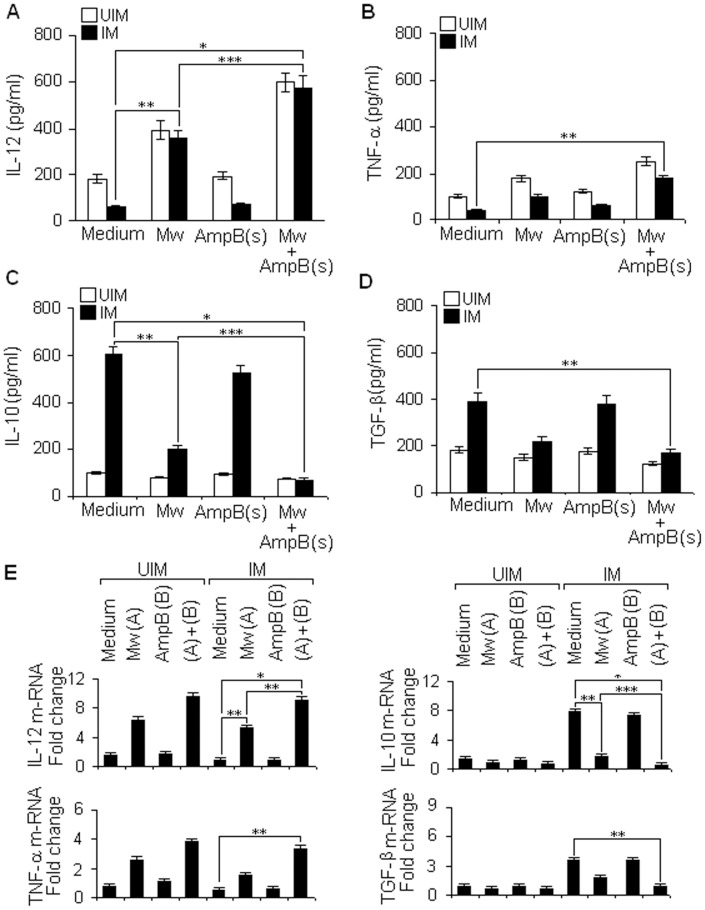

Mw shifts the cytokine response from Th2 to Th1 (A–E).Uninfected (UIM) or Leishmania infected (IM) macrophages (2×106 cells/ml) were treated with Mw (107cells/ml), AmpB (0.1 µg/ml), or Mw plus AmpB (0.1 µg/ml) for 20 h. Levels of IL-12p70 (A), TNF-α (B), IL-10 (C) and TGF-β (D) in the culture supernatant of differently treated sets were evaluated by sandwich ELISA, as described in Materials and Methods. (E) Total RNA was extracted from similarly treated uninfected or infected macrophages using TRIZOL and Real Time-PCR was performed to study mRNA expression of different pro-inflammatory and anti-inflammatory cytokines. Results are presented as mean values. The experiment was repeated 3 times, yielding similar results and data were expressed as mean ± SD. *P<0.001, **P<0.01 compared with infected macrophages and ***P<0.05 compared with Mw treated infected macrophages; paired two-tailed Student’s t-test.